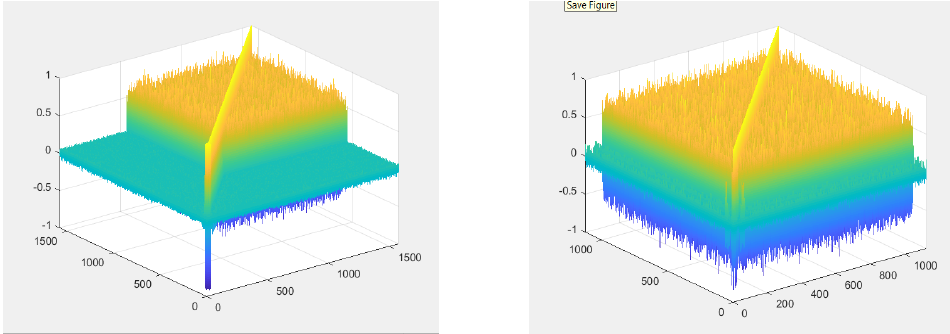
Figure A2. The correlations between the textural and CNN